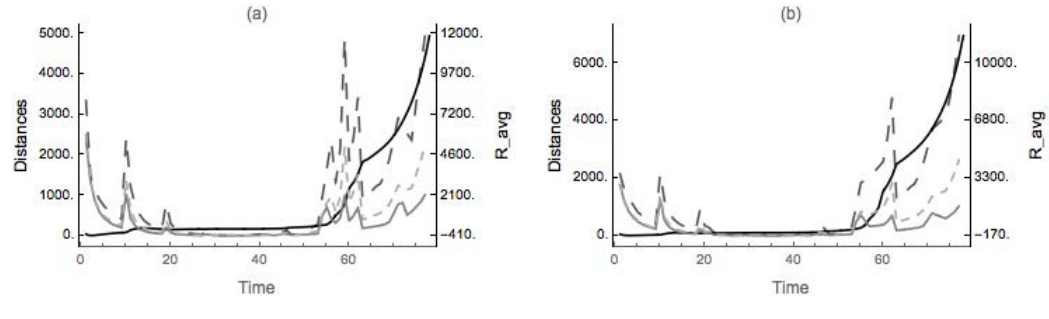
Figure 5. β 0 : interpolation functions of average scalar curvature (denoted by R_avg, solid black line), bottleneck (gray), Wasserstein-1 (dark gray, dashed), and Wasserstein-2 (light gray, dashed) distances for ( a ) N θ = 15 and ( b ) N θ =